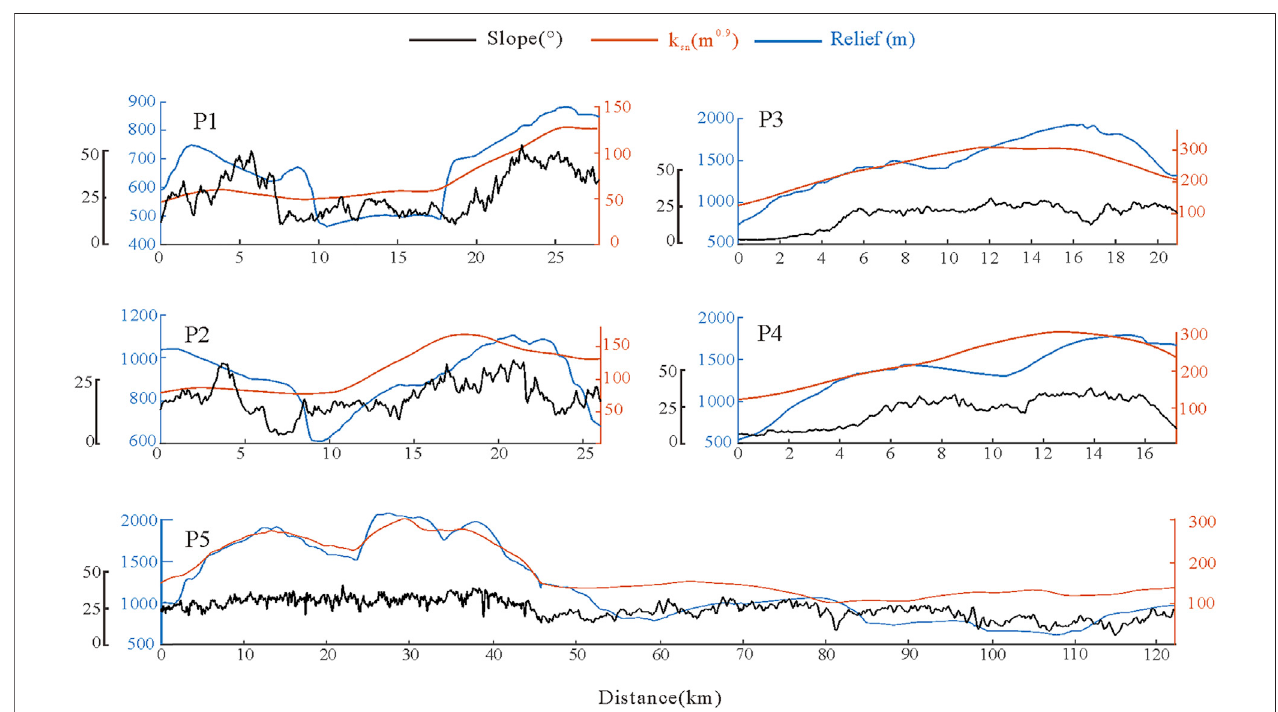
FIGURE5| Fivestripanalysispro fi les.Stripanalysispro fi lesincludetherelief,k sn ,andslope.Black,orange,andbluepresenttheslope,k sn ,andrelief,respectively.